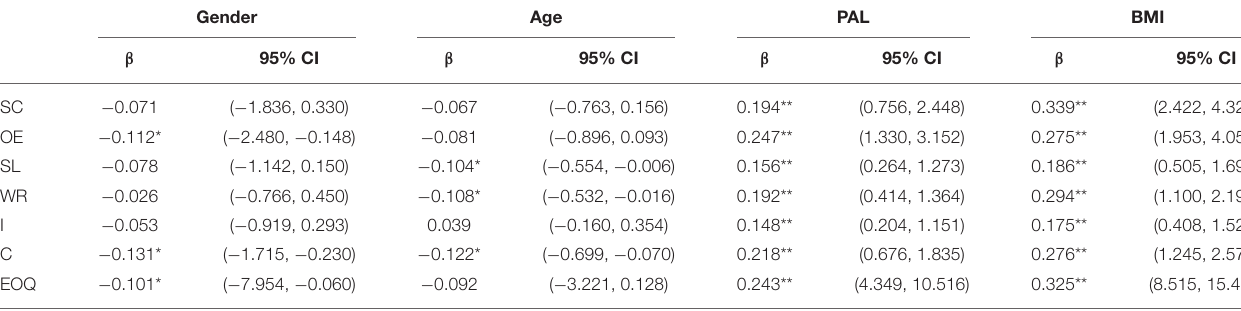
TABLE 8 | Standardized multiple regression coefficients (Partial β ) of Model-R3.